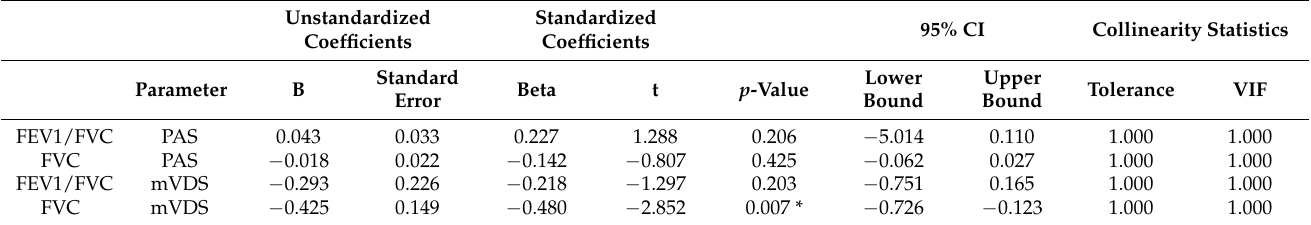
Table 5. Multivariate regression analysis (with the enter method) of the association between the penetration–aspiration scale (PAS) scores and PFT (FVC and FEV1/FVC) and between the modified version of the videofluoroscopic dysphagia scale (mVDS) scores and PFT (FVC and FEV1/FVC) in the patients with frailty-induced